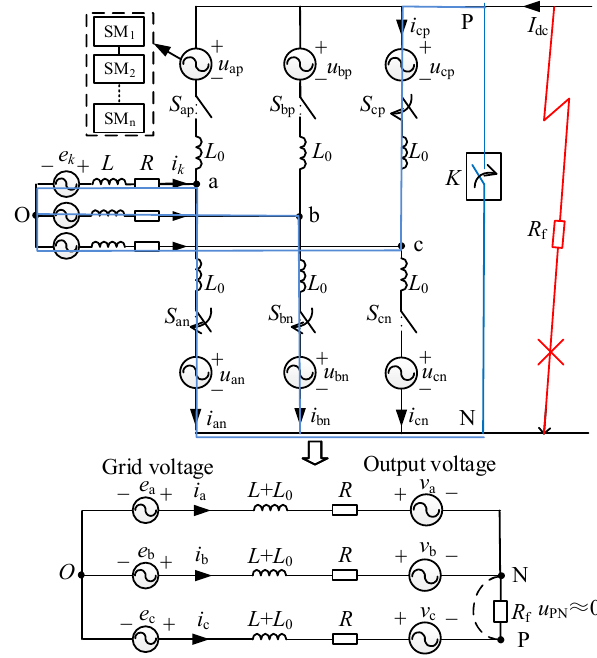
Figure 5. The equivalent circuit of MMC in the third section during the fault ride through.